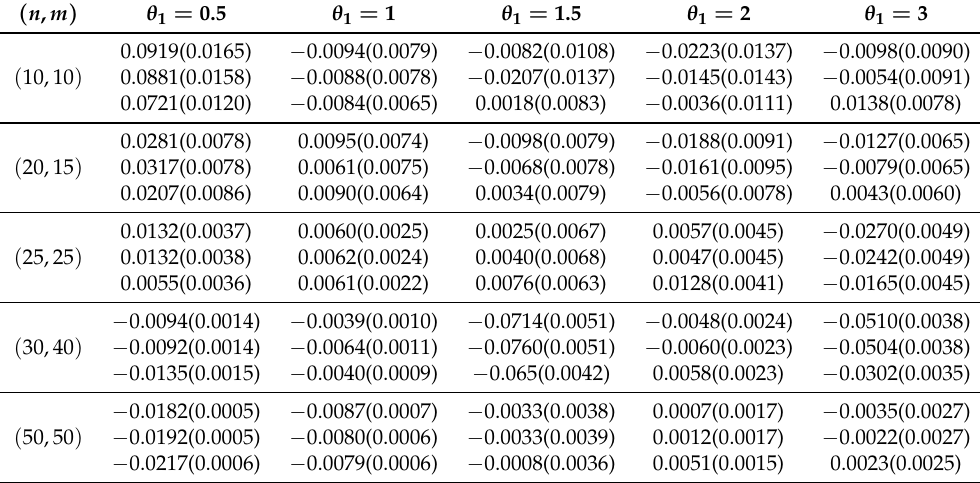
Table 1. Biases and mean square errors(MSEs) of the maximum likelihood estimate (MLE), approximate maximum likelihood estimate (AMLE) and Bayes estimate of R , when α = 2, θ 2 = 1 and for different values of θ 1 .